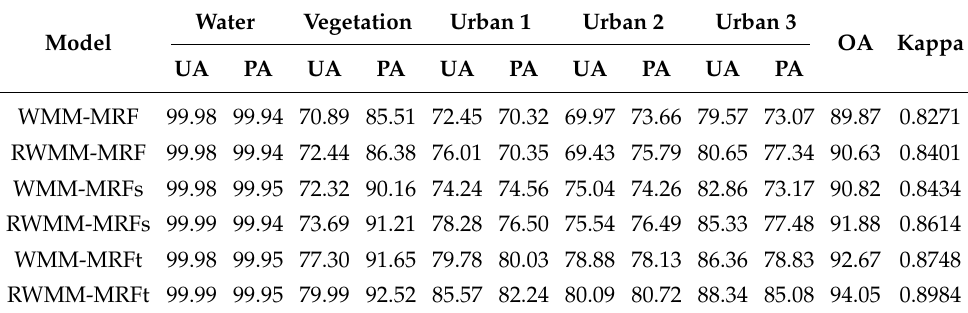
Table 5. Classification Accuracy (%) Of Six Different Algorithms on the San Francisco region.